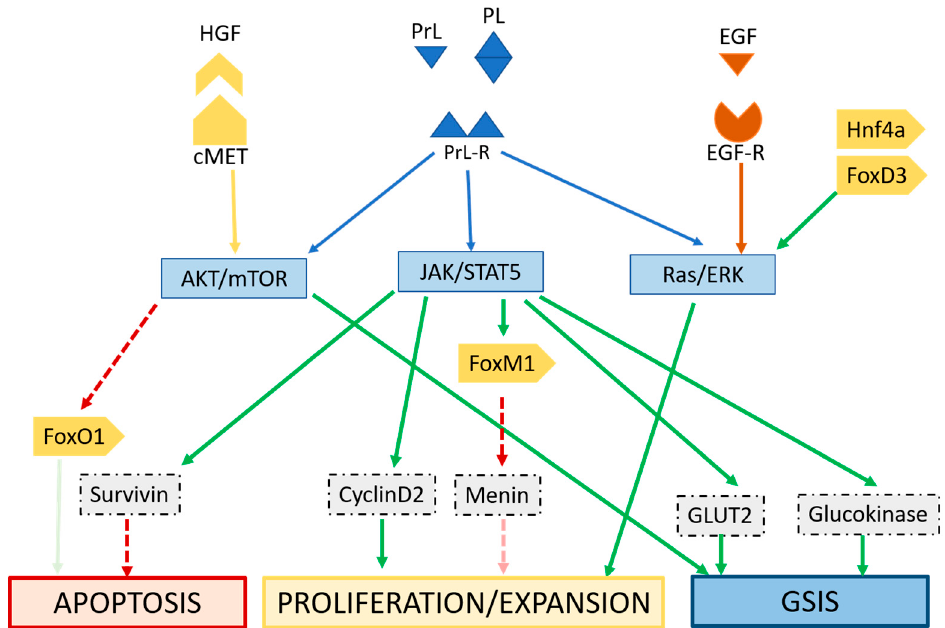
Figure 2. Signalling by pregnancy hormones prolactin (PrL) and placental lactogen (PL) through the prolactin receptor (PrlR) through the Jak/Stat pathway improves glucose stimulated insulin secretion (GSIS), prevents apoptosis and promotes proliferation and expansion. Hepatocyte growth factor (HGF) signals through AKT and mTOR via cMet to improve β -cell adaptations. Epidermal growth factor (EGF) through epidermal growth factor receptor (EGF-R) and ras/extracellular signal-related kinases (ERK) signalling can mediate proliferation and expansion; the ras/ERK pathway can also be mediated lactogens. Transcription factors (such as Hnf4a, FoxD3, FoxM1) can modulate expression of genes that mediate these adaptations.